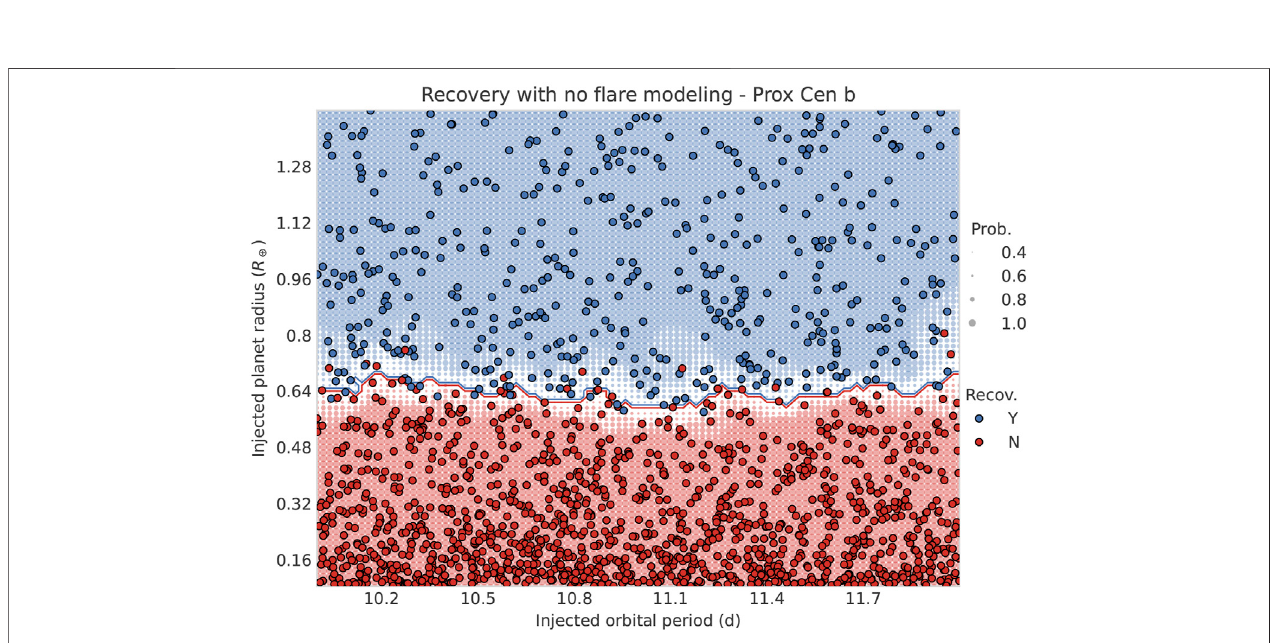
FIGURE4| Withoutaccountingfor fl aresinourplanetinjectionandrecoverytests,wearelesslikelytorecoverthesmallestplanets.This fi gureshowsthesensitivity to transiting planet when using sigma-clipping of fl ares, rather than fl are model subtraction. Compared to the fl are modeling sensitivity is 68% poorer.